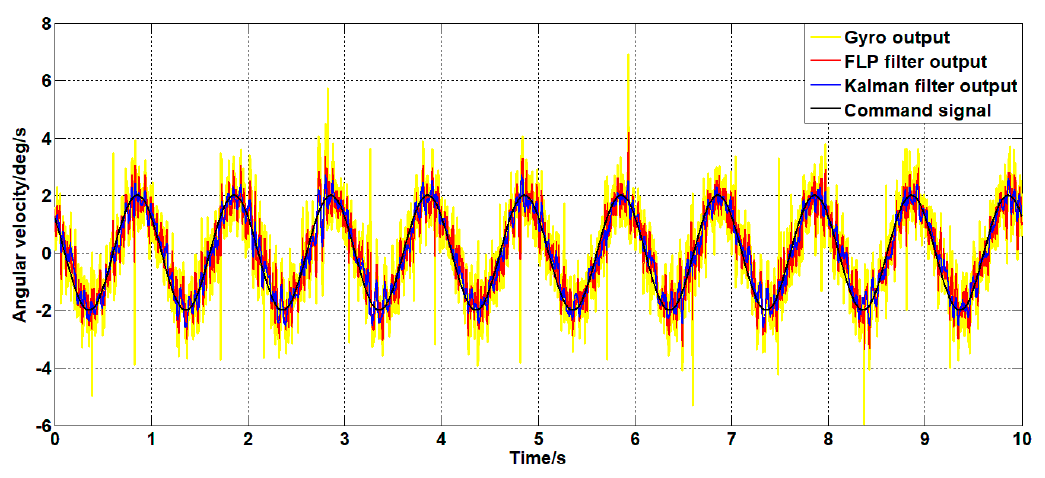
Figure 21. Filter curves for different filtering algorithms under dynamic commands.